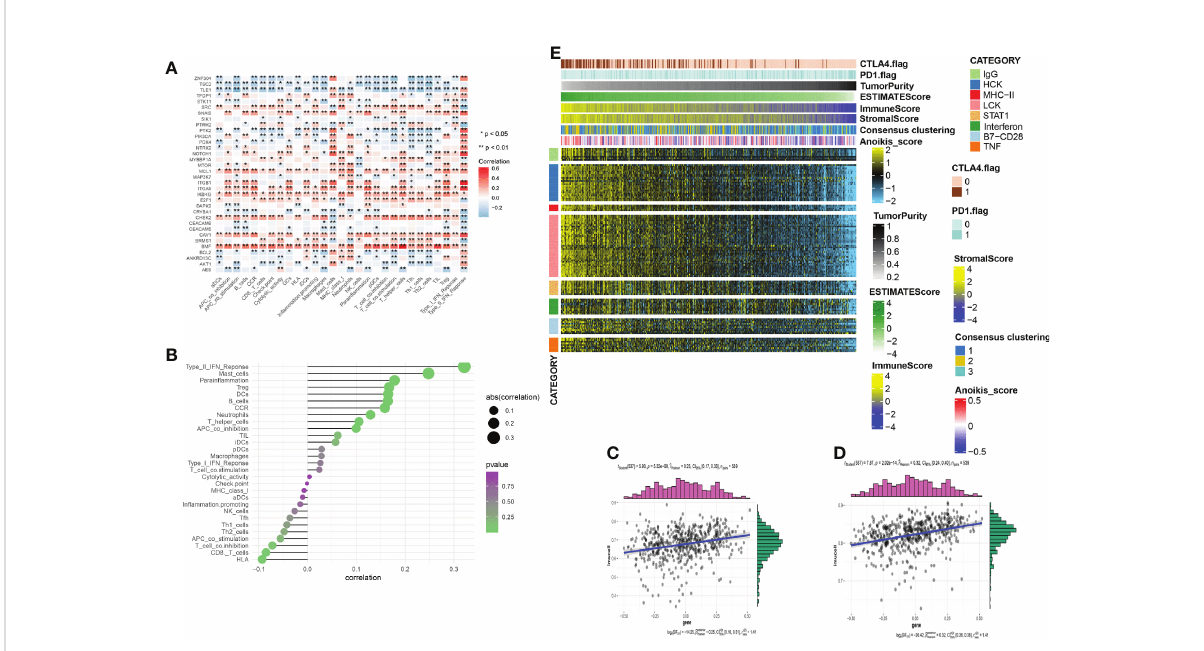
FIGURE 5 (A) The correlation between the immune in fi ltration and the anoikis-related genes. Red/blue represent a positive/negative correlation, respectively. (*p < 0:05, **p < 0:01). (B) The plotshows the degree ofcorrelation. The area ofthe circle represents the abs (correlation) and the color baronthe right side shows the p value. (C, D) Mast celland Type_II_IFN_reponse were selected, and the scatter diagram shows the correlation with anoikis score. (E) Toidentify the meta-genesof major expressionvectors associated with immunotherapy,wescreened the samples for some genes associated with 8 in fl ammatoryfactors. The expression ofthese genesand other immunotherapy-related scores in the KIRC